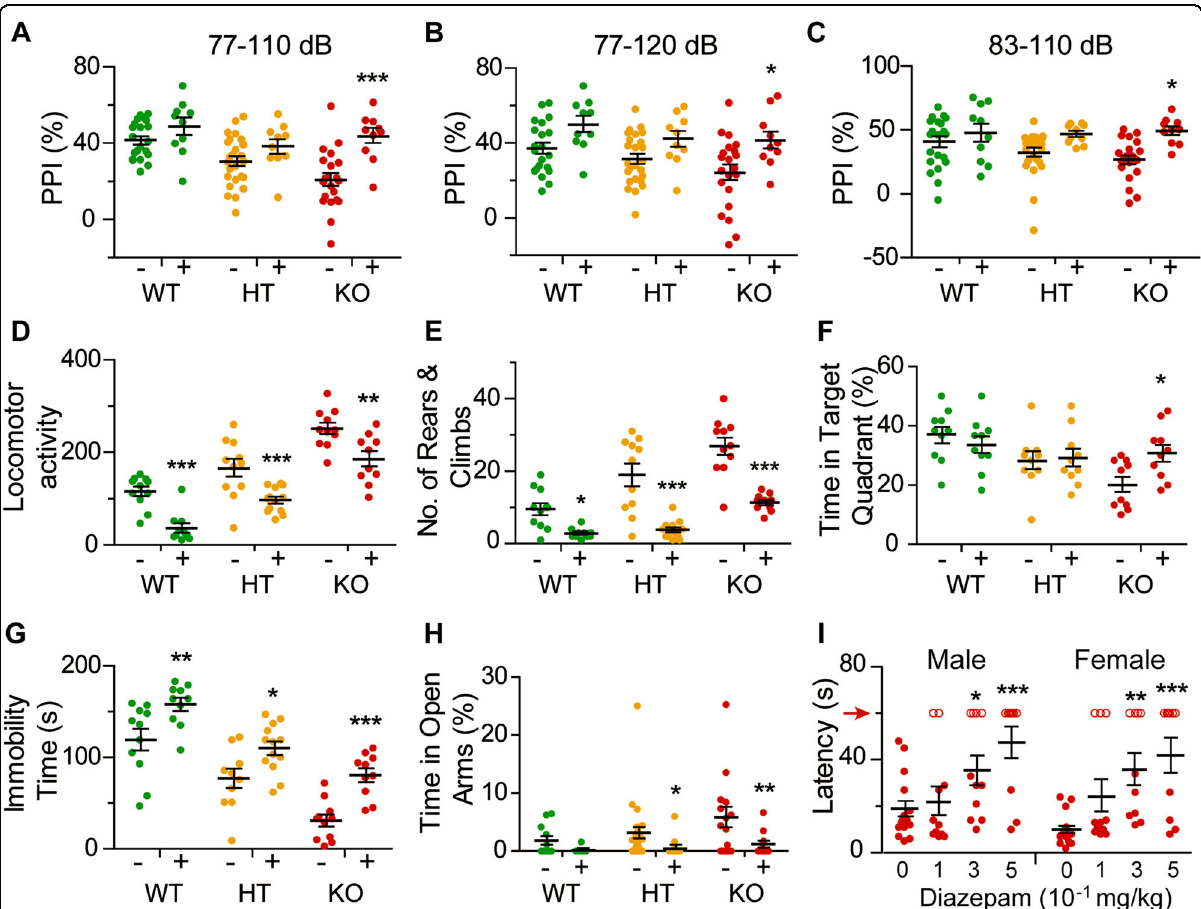
Fig. 3 Reversal of KO behavioral phenotypes by risperidone and diazepam. The behavior of WT, HT, or KO mice administered with 0.3 mg/kg risperidone i.p was compared that of control mice administered with saline in: a – c PPI trials with signi fi cant effects of risperidone in the 77 – 110, 77 – 120, and 83 – 110 dB prepulse-pulse trials ( F 1,92 = 19.20, p < 0.001; F 1,92 = 16.80, p < 0.001; and F 1,92 = 15.71, p < 0.001, respectively), and signi fi cant effects of genotype in the 77 – 110 and 77 – 120 dB prepulse-pulse trials ( F 2,92 = 8.04, p < 0.001; and F 2,92 = 3.53, p < 0.05, respectively). Saline group: WT male n = 21, HT male n = 25, KO male n = 21; risperidone group: WT male n = 10, HT male n = 10, KO male n = 10. d Locomotor activity test with signi fi cant effects of risperidone ( F 1,95 = 49.87, p < 0.0001) and of genotype ( F 2,95 = 51.78, p < 0.0001). Saline group: WT male n = 11, HT male n = 11, KO male n = 11; risperidone group: WT male n = 10, HT male n = 13, KO male n = 10. e Behavioral stereotypy test based on rears and climbs with signi fi cant effects of risperidone ( F 1,60 = 72.57, p < 0.0001) and of genotype ( F 2,60 = 25.33, p < 0.0001). Saline group: WT male n = 11, HT male n = 11, KO male n = 11; risperidone group: WT male n = 10, HT male n = 13, KO male n = 10. f Morris water maze test with signi fi cant effect of genotype ( F 2,54 = 6.20, p < 0.01). Saline group: WT male n = 10, HT male n = 10, KO male n = 10; risperidone group: WT male n = 10, HT male n = 10, KO male n = 10. g Tail-suspension test with signi fi cant effects of risperidone ( F 1,59 = 32.92, p < 0.0001) and of genotype ( F 2,59 = 43.82, p < 0.0001). Saline group: WT male n = 11, HT male n = 10, KO male n = 11; risperidone group: WT male n = 10, HT male n = 13, KO male n = 10. h Elevated-plus maze test with signi fi cant effect of risperidone ( F 1,96 = 13.29, p < 0.001). Saline group: WT male n = 12, HT male n = 25, KO male n = 16; risperidone group: WT male n = 12, HT male n = 25, KO male n = 12. i Audiogenic epilepsy with signi fi cant effects of diazepam ( F 3,87 = 12.47, p < 0.001). Saline group: KO male n = 16, KO female n = 16; 0.1 mg/kg diazepam group: KO male n = 11, KO female n = 11; 0.3 mg/kg diazepam group: KO male n = 11, KO female n = 10; 0.5 mg/kg diazepam group: KO male n = 10, KO female n = 10. Latency periods were capped at the maximum cutoff of 60 seconds. In (a – h) , ‘ + ’ denotes animals administered with 0.3 mg/kg risperidone i.p, and ‘ − ’ animals administered with saline i.p. In ( i) , the different groups were treated with 0 – 0.5 mg/kg diazepam i.p. WT is represented by green dots, HT by orange dots, and KO by red dots except in ( i) where KO mice reaching the 60-s cutoff are represented by red open circles. Average y values ± SEM in the different plots are represented by horizontal bars. Statistical analysis was performed using two-way ANOVA with Dunnett ’ s post-hoc test; * p < 0.05, ** p < 0.01, and *** p < 0.001 in all the post-hoc